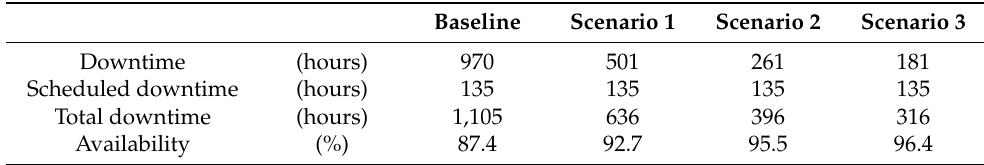
Table 6. Predicted availability for each scenario in Japan.